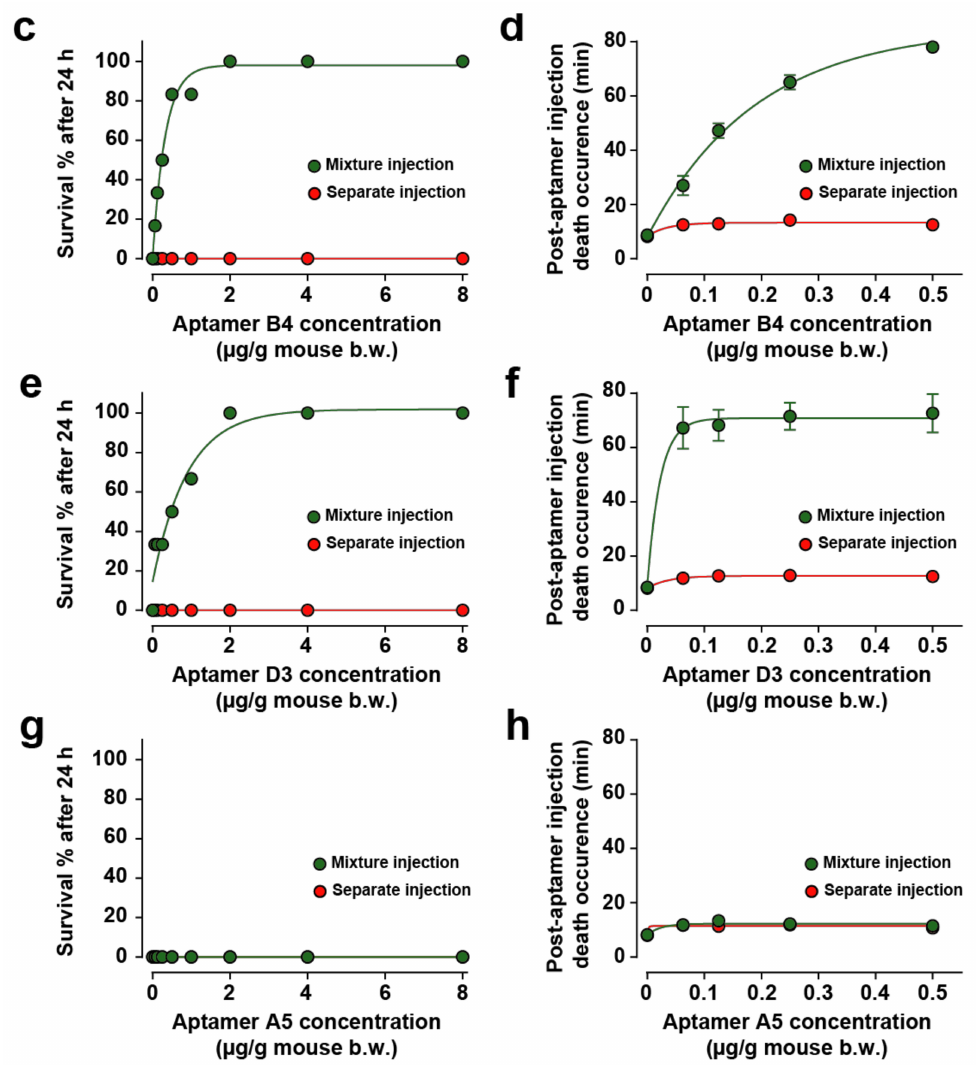
Figure 4. In vivo evaluation of aptamer neutralization properties. ( a , b ) Dose-response curve illustrating aptamer D7 neutralization properties on death rescue ( a ) and latency to death ( b ). One set of data was previously published in [8]. ( c , d ) Dose-response curve illustrating aptamer B4 neutralization properties on death rescue ( c ) and latency to death ( d ). ( e , f ) Dose-response curve illustrating aptamer D3 neutralization properties on death rescue ( e ) and latency to death ( f ). ( g , h ) Dose-response curve illustrating aptamer A5 neutralization properties on death rescue ( e ) and latency to death ( f ). Aptamers and toxin were administrated by intraperitoneal injection (mixture injection condition, green symbols and lines) or aptamers were injected by the intravenous route 1 min after intraperitoneal toxin injection (red symbols and lines). For each aptamer, α C-conotoxin PrXA concentration of 0.5 µ g/g of mouse body weight was used. n = 6 mice for each aptamer concentration. n = 54 mice for each route of